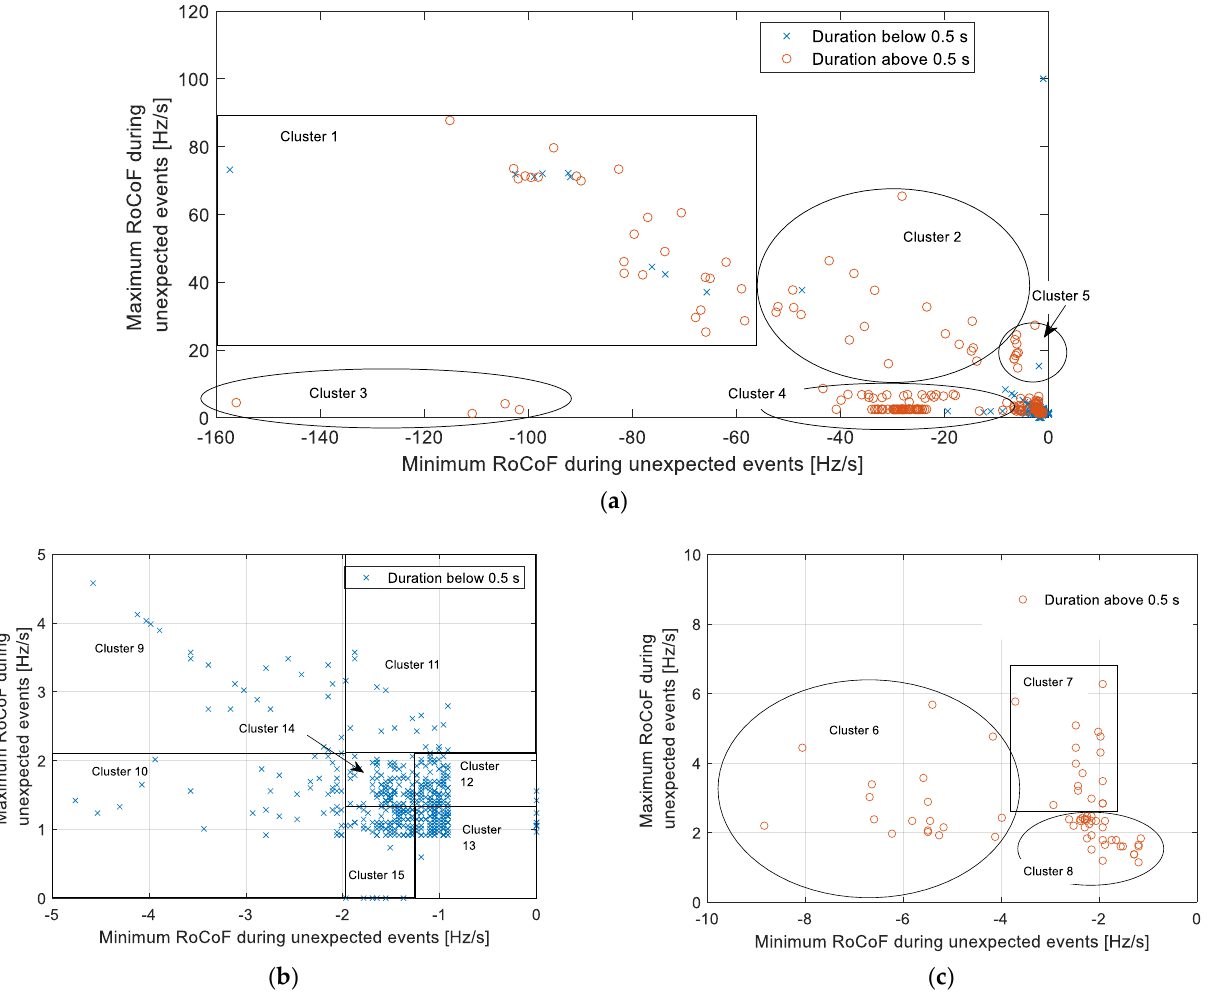
Figure 6. Cluster of grid frequency events depending on the maximum and minimum ocurring RoCoFs and the event duration. ( a ) Short and long event for very high RoCoFs. ( b ) Short events for smaller RoCoFs. ( c ) Long events for smaller RoCoFs. ( b , c ) are an excerpt from ( a ) giving a detailed view of events with less extreme RoCoFs. Table 2. Overview of identified event scenarios for the load